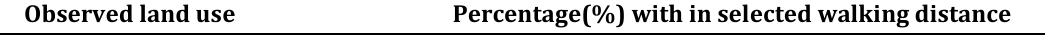
Table 7: Accessibility indicator (A)